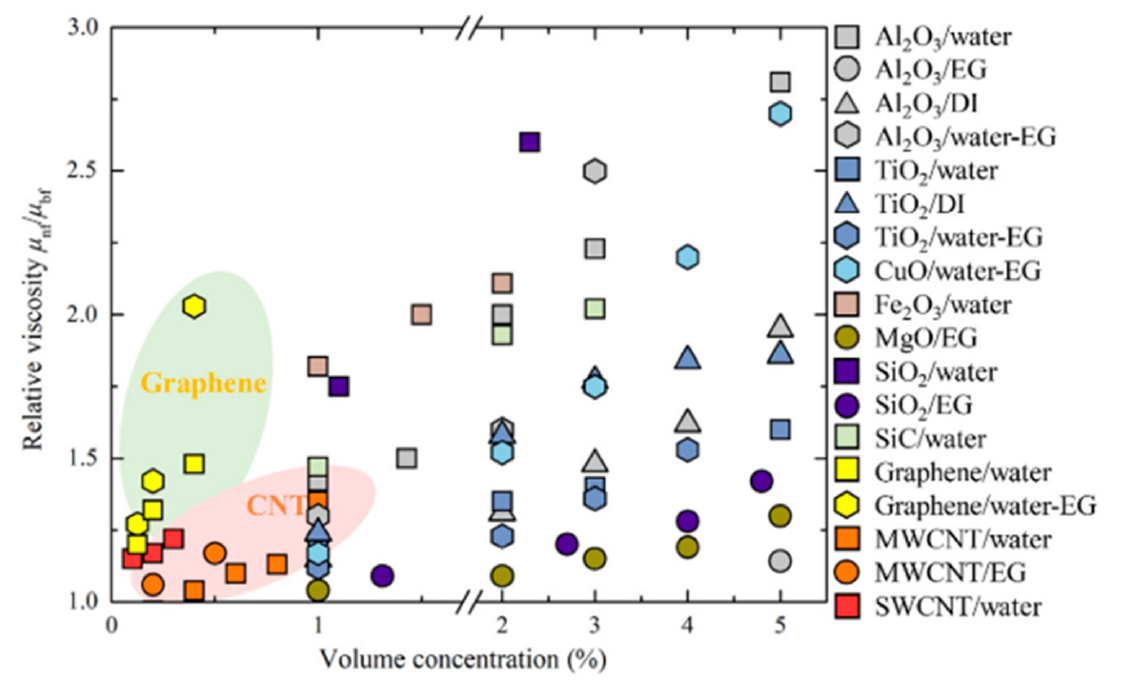
Figure 13. A schematic diagram for the dependence of viscosity on the volume concentration of nanoparticles in various studies [173].